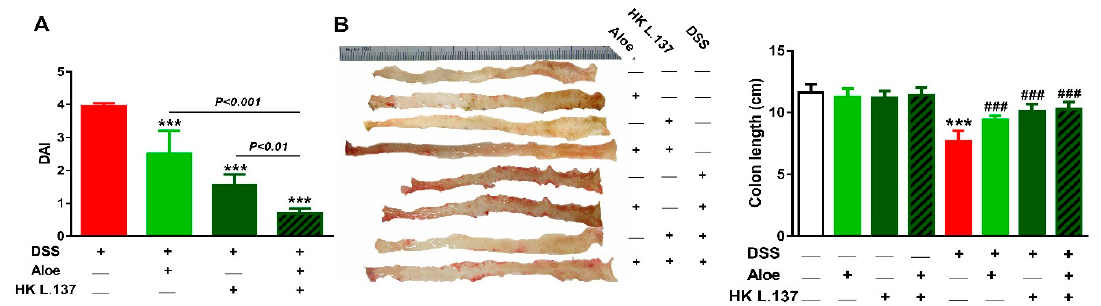
Figure 2. E ff ect of Aloe vera extract (Aloe) and / or heat-killed Lactobacillus plantarum L.137 (HK L.137) on disease activity index (DAI) ( A ) and colon length ( B ) in control and dextran sodium sulfate (DSS)-induced mice. Data are mean ± SD, n = 6. *** p < 0.001 versus DSS. *** p < 0.001 versus Control and ### p < 0.001 versus DSS.